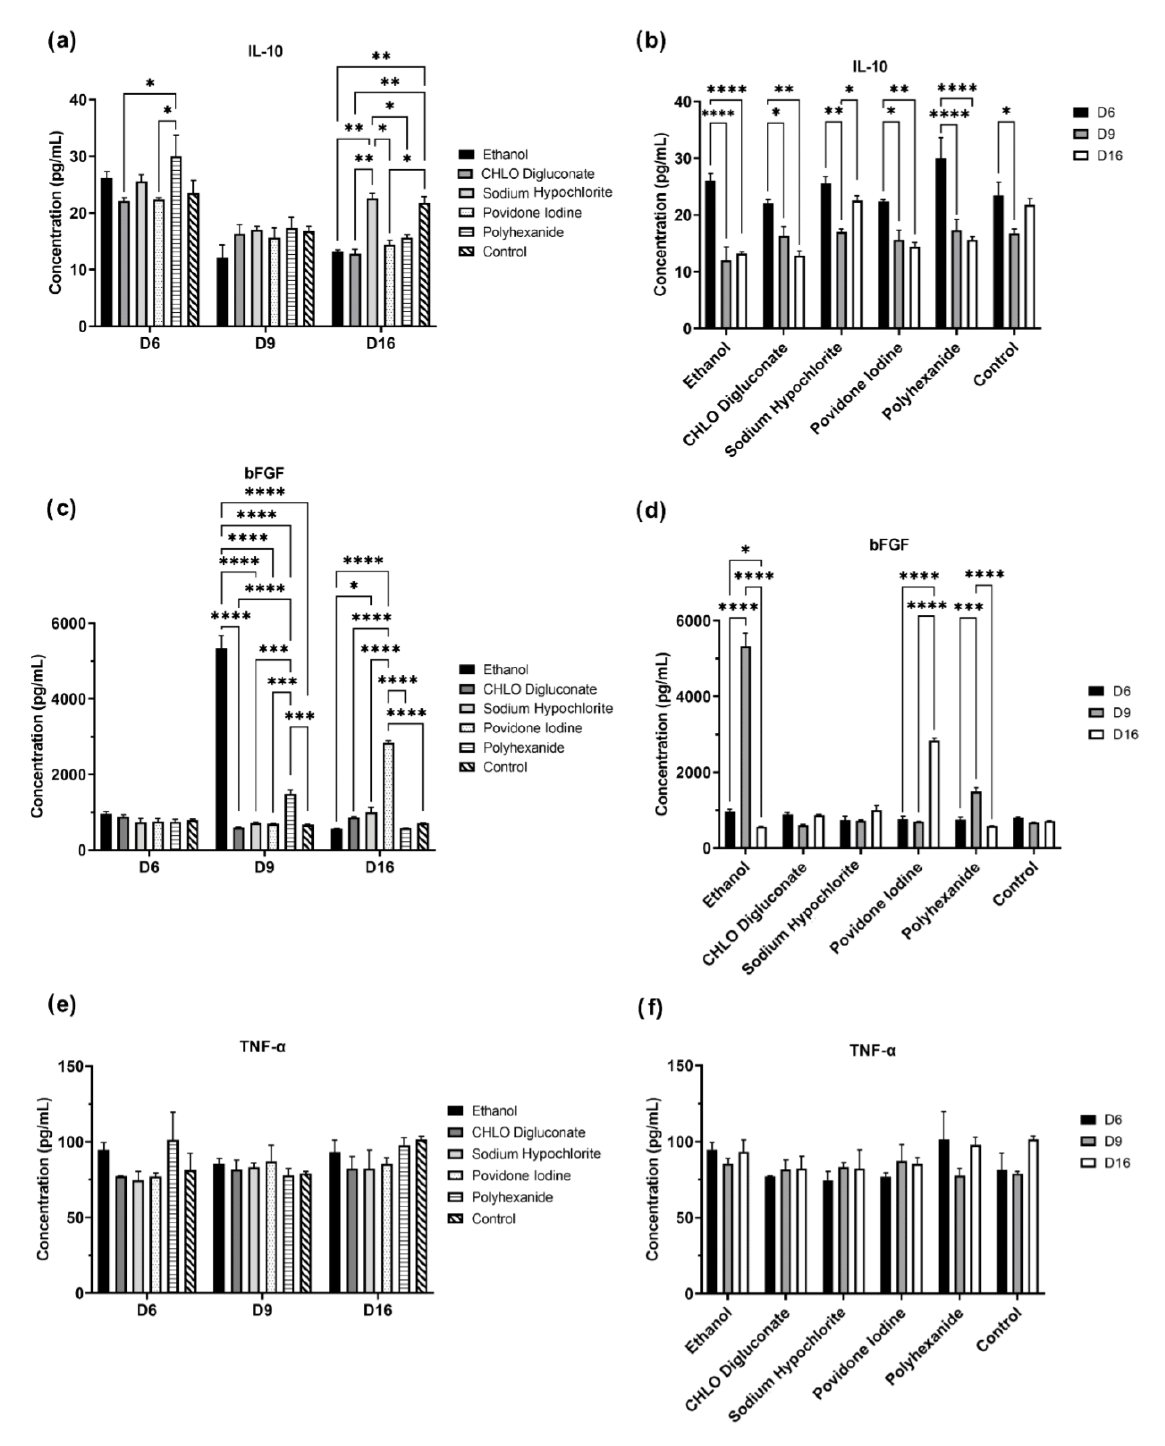
Figure 4. Statistical analysis of cytokine concentration levels in BASS supernatant on days 6, 9, and 16. Corresponding to IL-10 ( a , b ), bFGF ( c , d ), and TNF- α ( e , f ). n =3. Significances were represented as * p < 0.05; ** p < 0.01; *** p < 0.001; **** p < 0.0001.